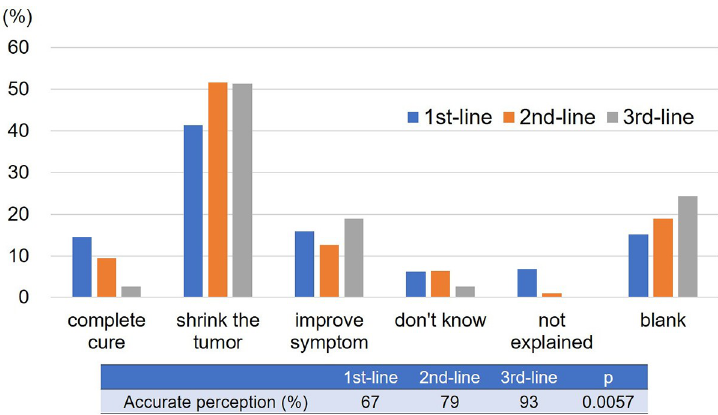
Fig 1. The response and the change in the response rate to Question 1. The percentage of patients who accurately perceived the objective of pharmacotherapy increased over the course of pharmacotherapy.